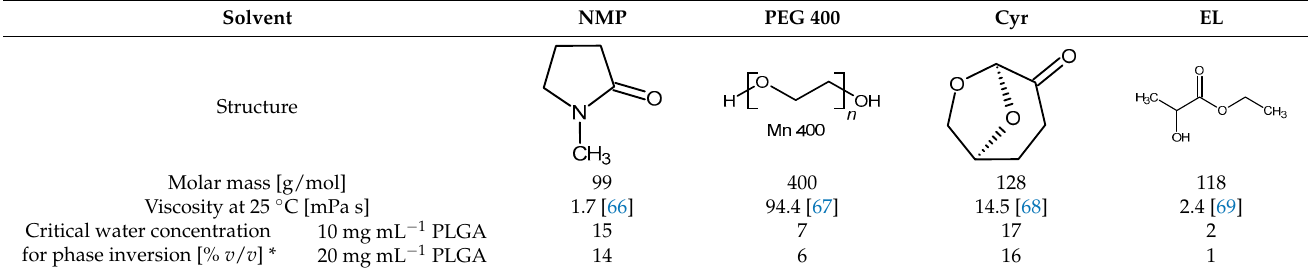
Table 1. Comparison of the physicochemical characteristics of the used solvents (* = experimental data). NMP